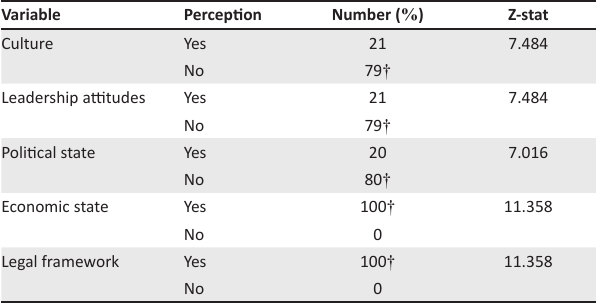
TABLE 3: Sign test results on drought relief enablers. Variable